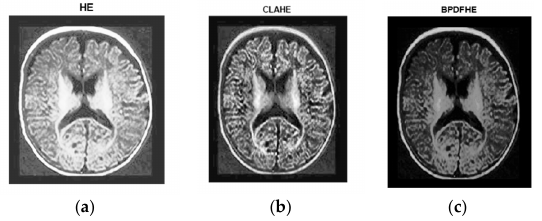
Figure 8. Preprocessed with ( a ) HE, ( b ) CLAHE, and ( c ) BPDFHE.